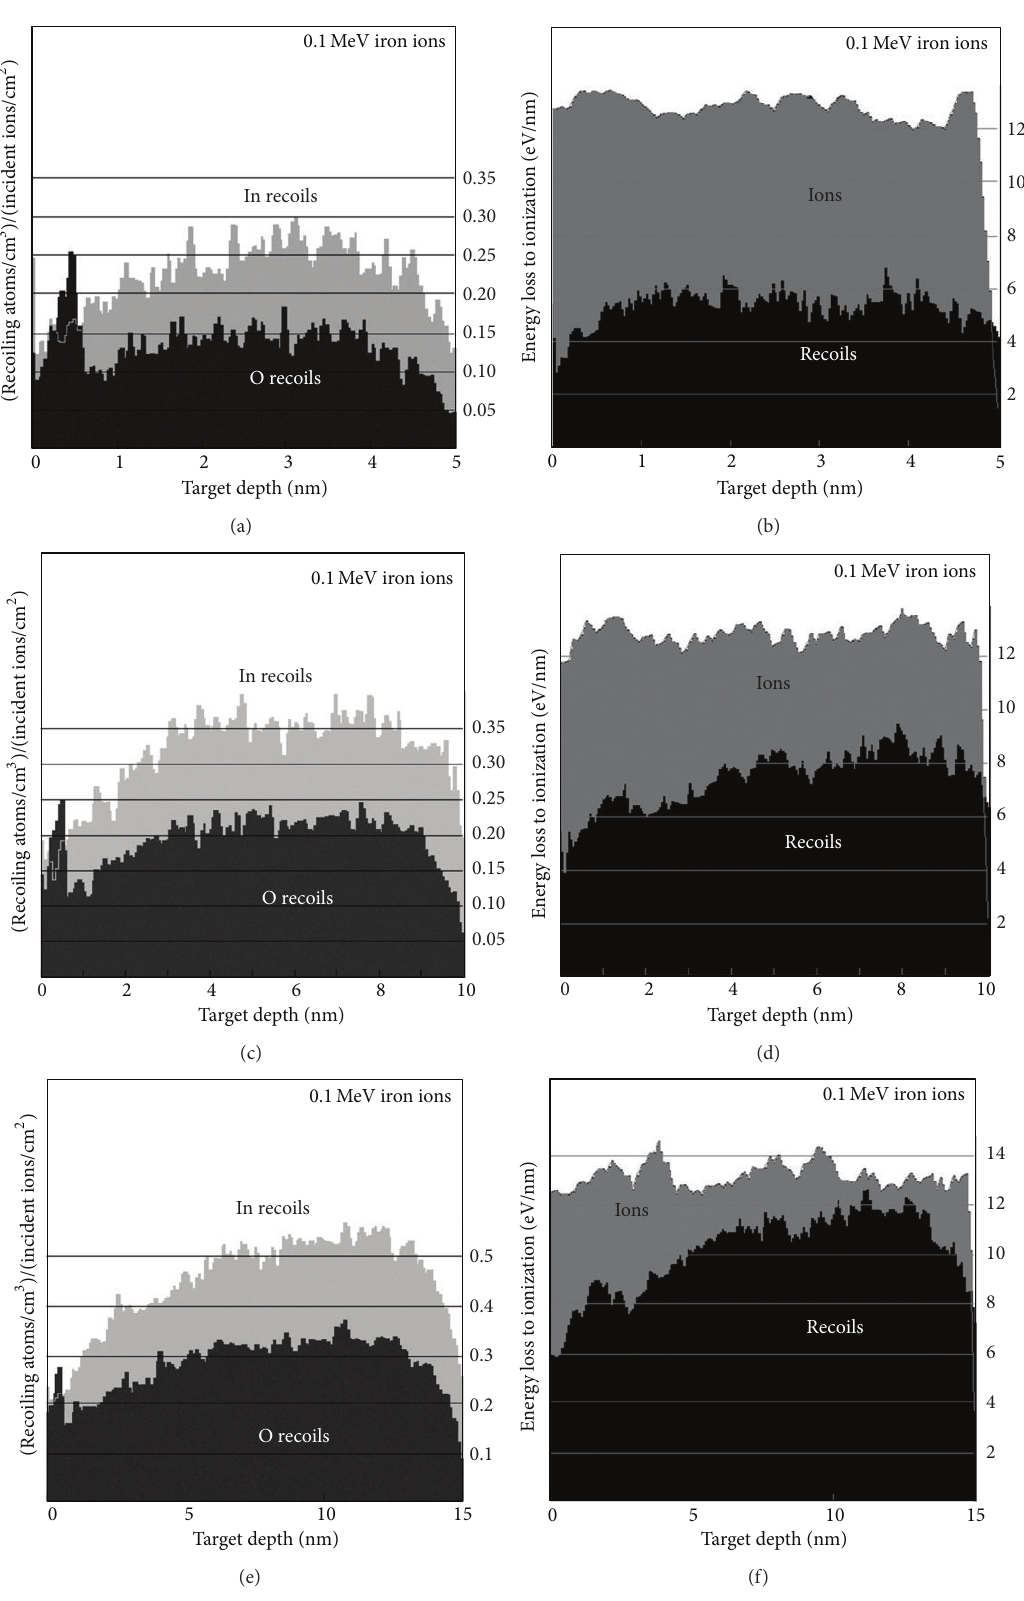
Figure 4: Results for 10 3 iron ions with 0.1MeV energy. Distribution of the concentration of the recoils per unit ion fluence and ionization energy losses per unit depth for various thicknesses of the InO 𝑥 film: 5nm (a and b), 10nm (c and d), and 15nm (e and